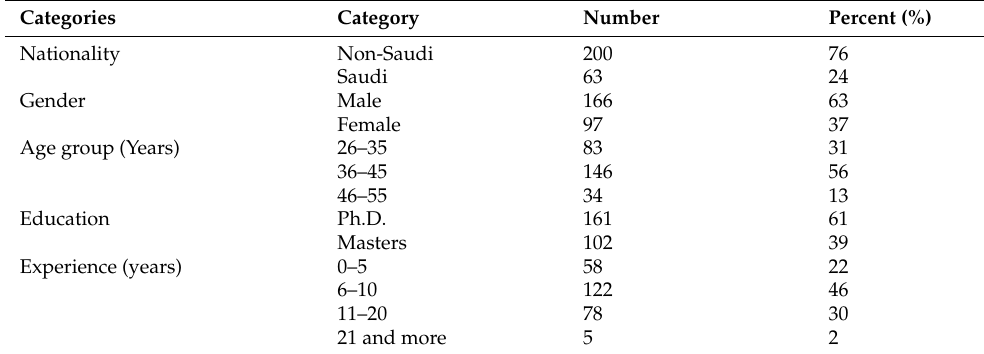
Table 1. Socio-demographic profile of the respondents.